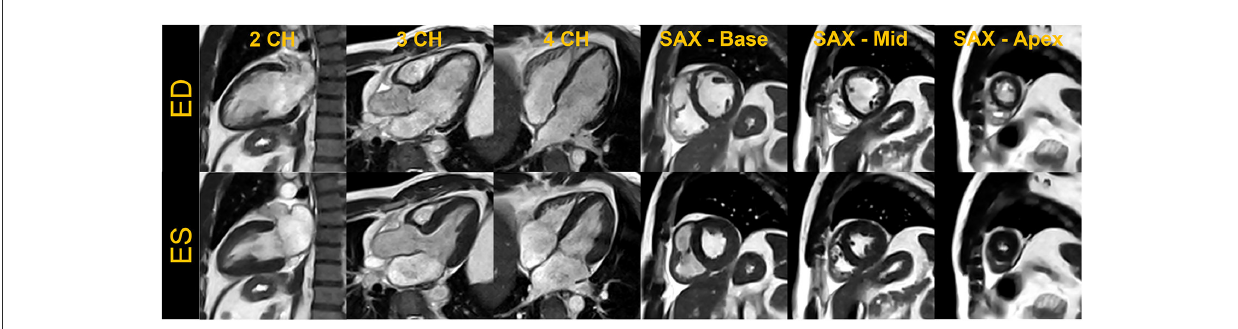
FIGURE2 End-diastole (ED) and end-systole (ES) cardiac frames from a compressed sensing-based breath-held segmented balanced steady-state free precession cine. Images acquired from a single volunteer are shown in standard cardiac views– two-chamber (2CH), three-chamber (3CH), four-chamber (4CH) and base, mid, and apical slices in short-axis